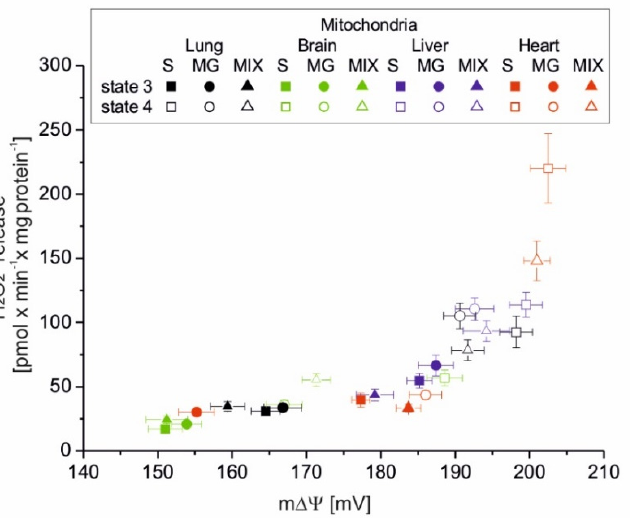
Figure 4. The relationship between H 2 O 2 release and m ∆Ψ in isolated rat mitochondria oxidizing succinate (S), malate plus glutamate (MG), and a mixture of succinate and malate plus glutamate (MIX) under phosphorylating (state 3) and nonphosphorylating (state 4) conditions. Mean ± SD; n = 5.